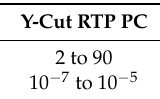
Table 2. SH and TH efficiencies normalized on SH in Y-cut KTP